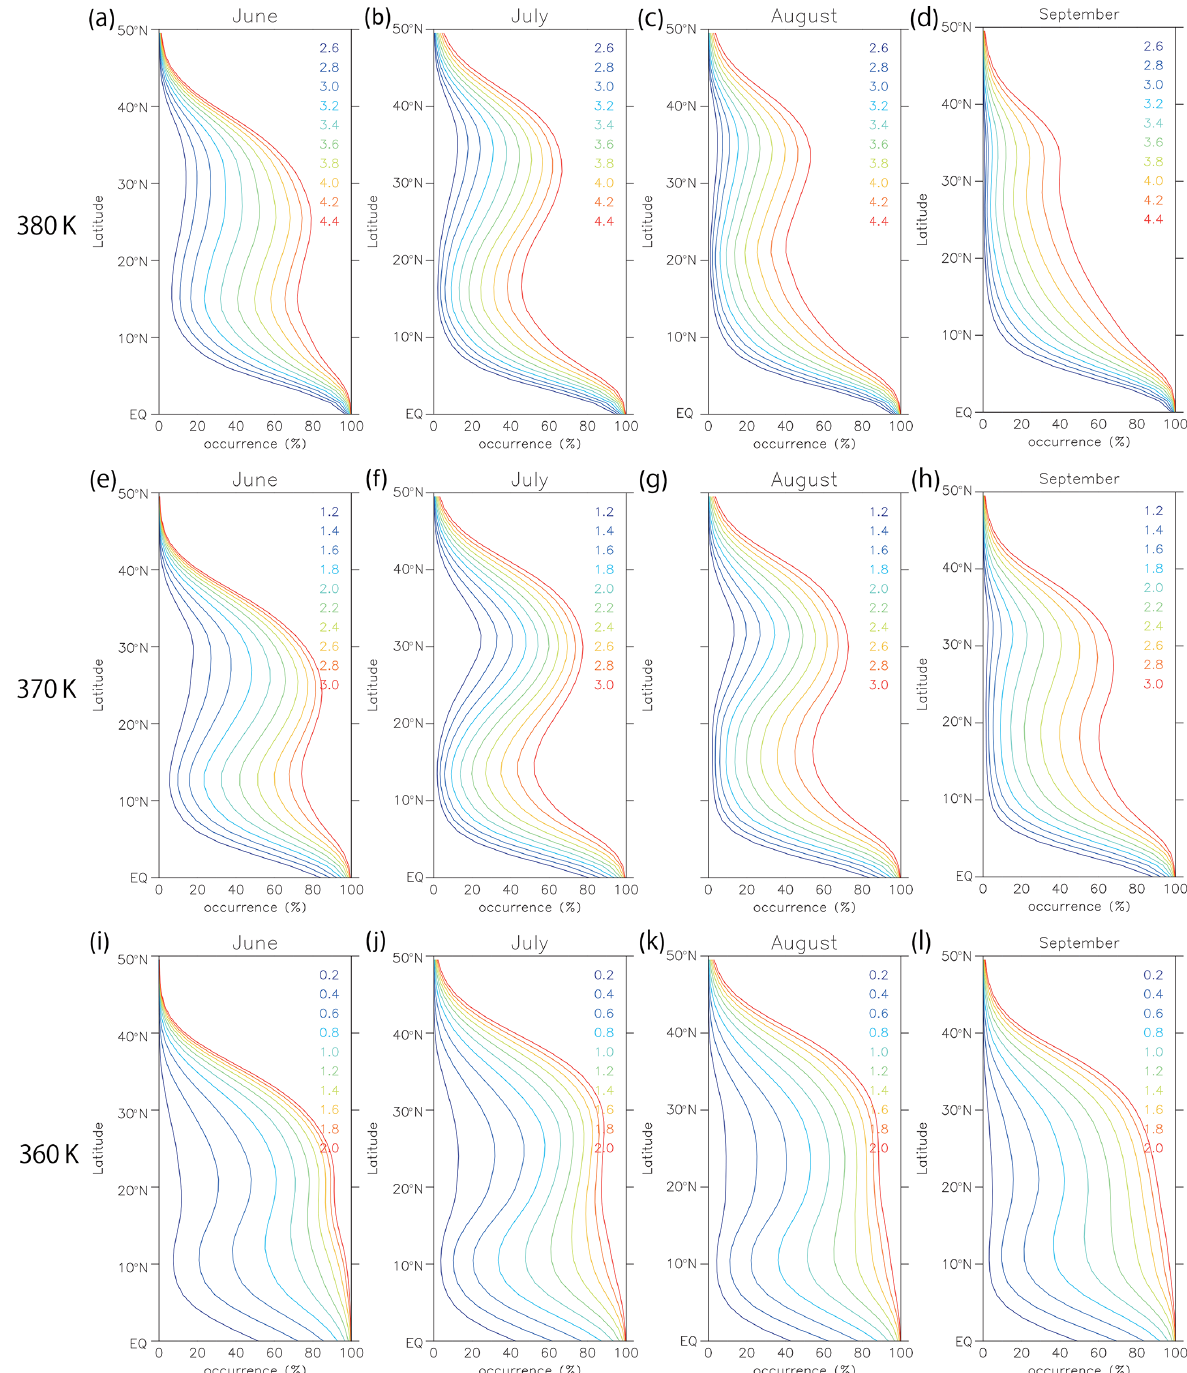
Figure A1. Percentage of the occurrence of grid points where PV is below the reference value between 0 and 160 ◦ E, as functions of latitude, calculated using ERA-Interim data from 1979 to 2016. Different line colors correspond to the different reference PV values that are shown in the top right of each